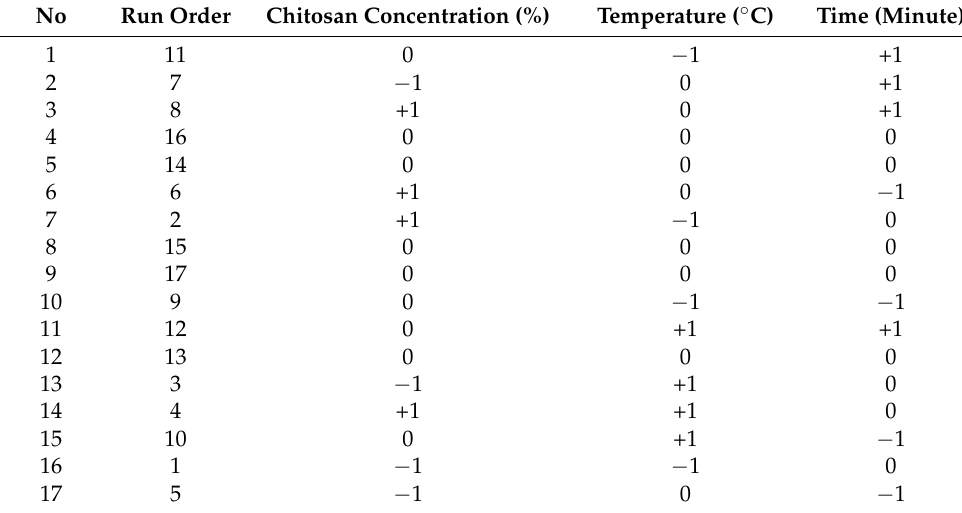
Table 3. Box Bhenken design for three factors and three